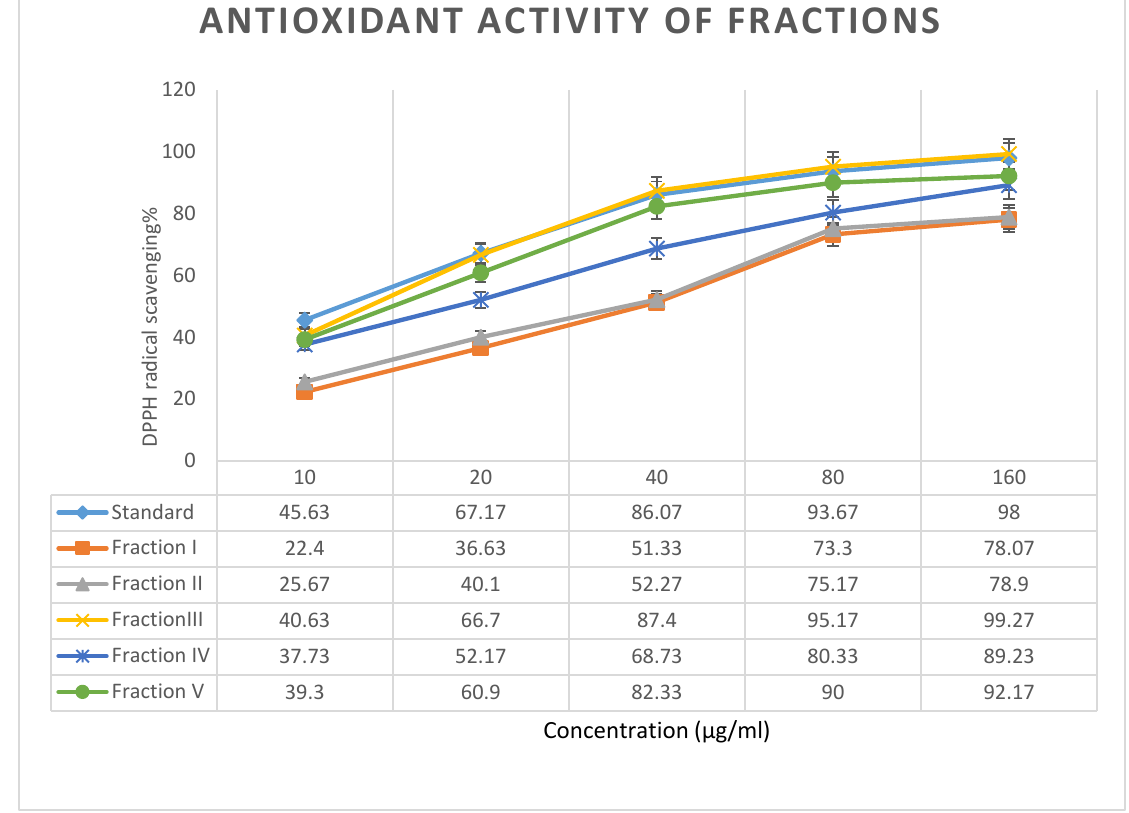
Figure 2. Antioxidant and free radical scavenging activity of isolated fractions. Table 3. Ferric reducing antioxidant power of different fractions.